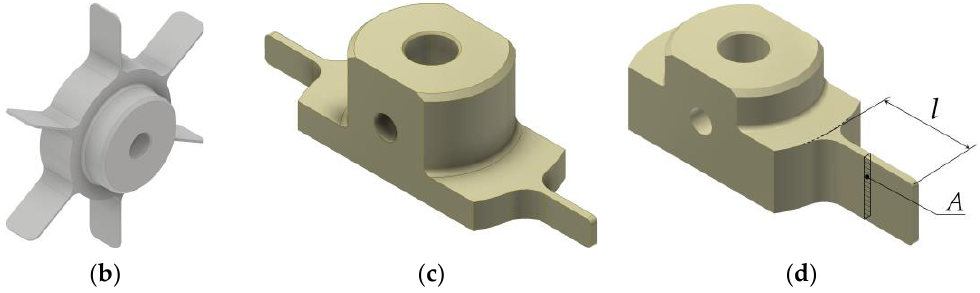
Figure 2. Considered rectangular plectrum shape ( a ), rotor equipped with six plectra ( b ) [34] and example of a two-plectra motor [15] ( c ), as well as the single-plectrum rotor design used in this work ( d ).